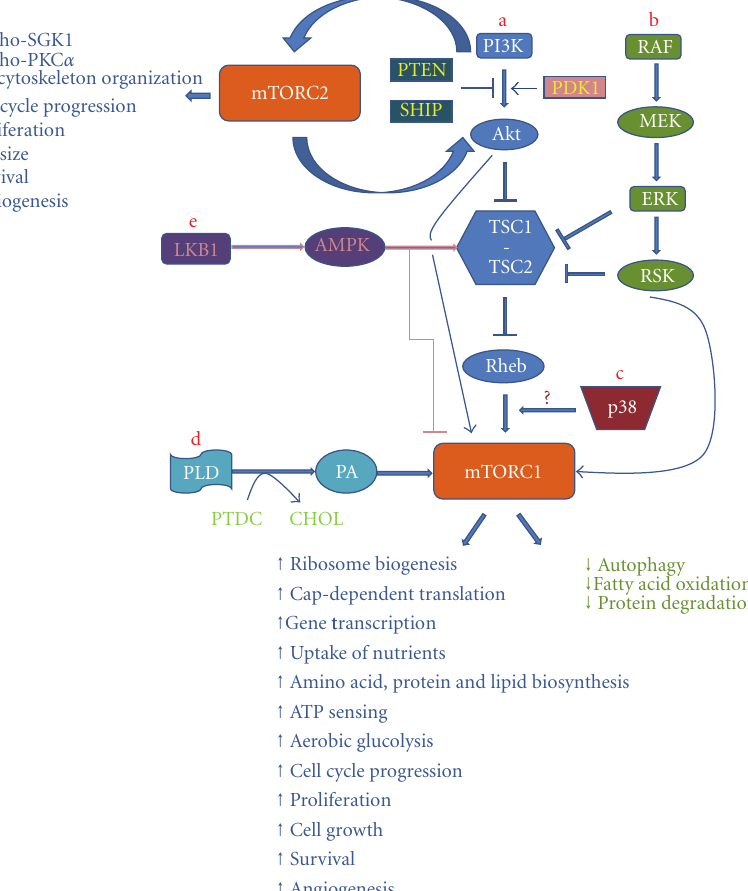
Figure 1: Molecular signalingcascadeswhich normallycontrol mTORC1 activity and may become dysregulated in B-cell lymphomasleading to aberrant mTORC1 signaling activation. The figure also demonstrates the functions of mTORC1 and mTORC2. (a) PI3K/Akt pathway: upon activation PI3K most possibly induces mTORC2 complex stimulation and also promotes the translocation of Akt and PDK1 to the cell membrane, where Akt becomes activated by PDK1 and mTORC2. Then, Akt activates mTORC1 by way of two mechanisms: (1) indirectly through downregulation of the inhibitory e ff ect of the TSC1-TSC2 complex on Rheb protein and (2) directly through phosphorylation of PRAS40 (proline-rich Akt substrate of 40 kilodaltons), which is a component of the mTORC1 complex. The tumor suppressor phosphatases PTEN and SHIP oppose PI3K-mediated Akt activation. (b) RAF/MEK/ERK pathway: once activated this pathway triggers mTORC1 activity indirectly through inactivation of the TSC1-TSC2 complex by ERK and RSK (ribosomal S6 kinase, 90kDa). The RAF/MEK/ERK pathway also directly activates mTORC1 through excitatory phosphorylation of raptor, a component of the mTORC1 complex, by RSK. (c) p38 is suggested to induce mTORC1 activity by acting downstream of or in parallel to Rheb. (d) PLD/phosphatidic acid (PA) pathway: upon activation PLD hydrolyzes phosphatidylcholine (PTDC) to generate choline (CHOL) and PA. Subsequently, PA activates mTORC1 by an unknown mechanism. (e) LKB1/AMP-dependent protein kinase (AMPK) pathway: the tumor suppressor kinase LKB1 activates AMP- dependent protein kinase (AMPK). AMPK, in turn, inhibits mTORC1 through activation of the TSC1-TSC2 complex and direct inhibitory phosphorylation of